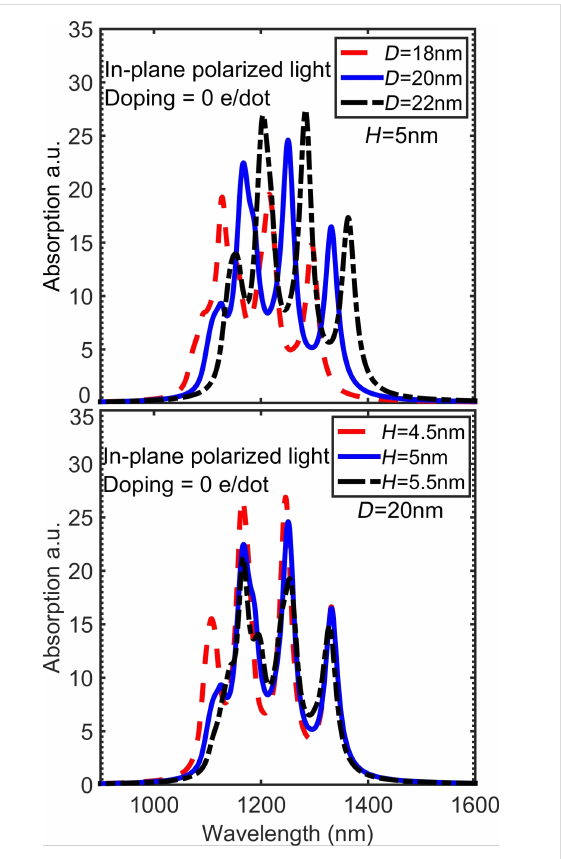
Figure 8: The in-plane polarized absorption spectrum calculated for (A) different diameters and (B) different heights of the quantum dot. In- creasing the dot diameter results in a shift of the peaks towards longer wavelengths, while increasing the dot height does not have a signifi- cant effect on the